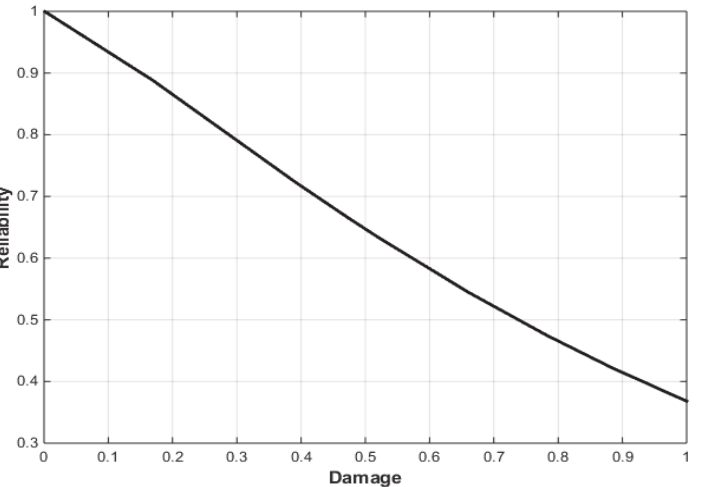
Figure 10: Graphic illustration of reliability versus